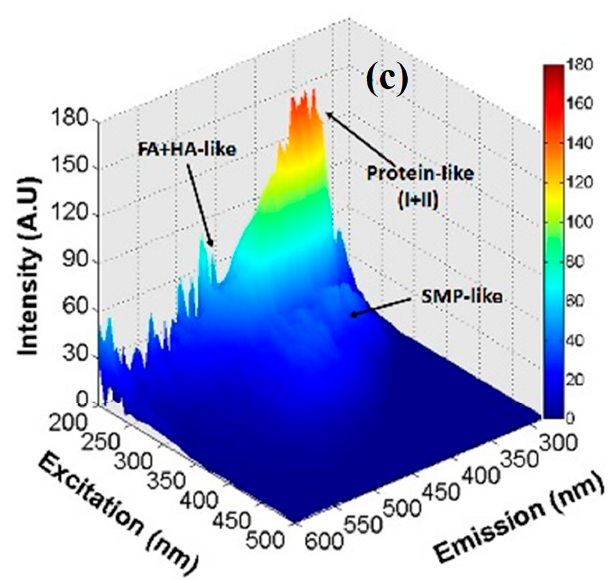
Figure 7. 3D view of fluorescence spectra of foulants extracted from fouled membranes at the end of filtration (dead-end filtration protocol): ( a ) 10 kDa; ( b ) 50 kDa, and ( c ) 100 kDa.